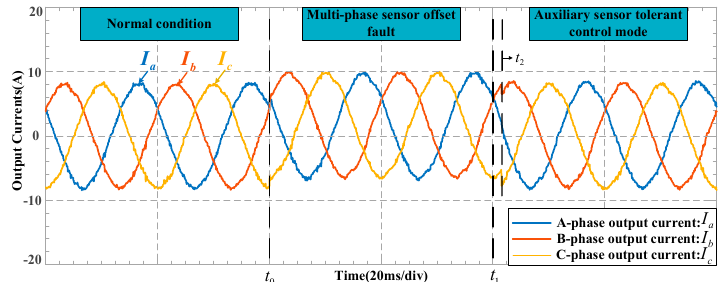
Figure 11. Experimental results for multi − phase sensor offset fault using auxiliary sensor tolerant control mode.